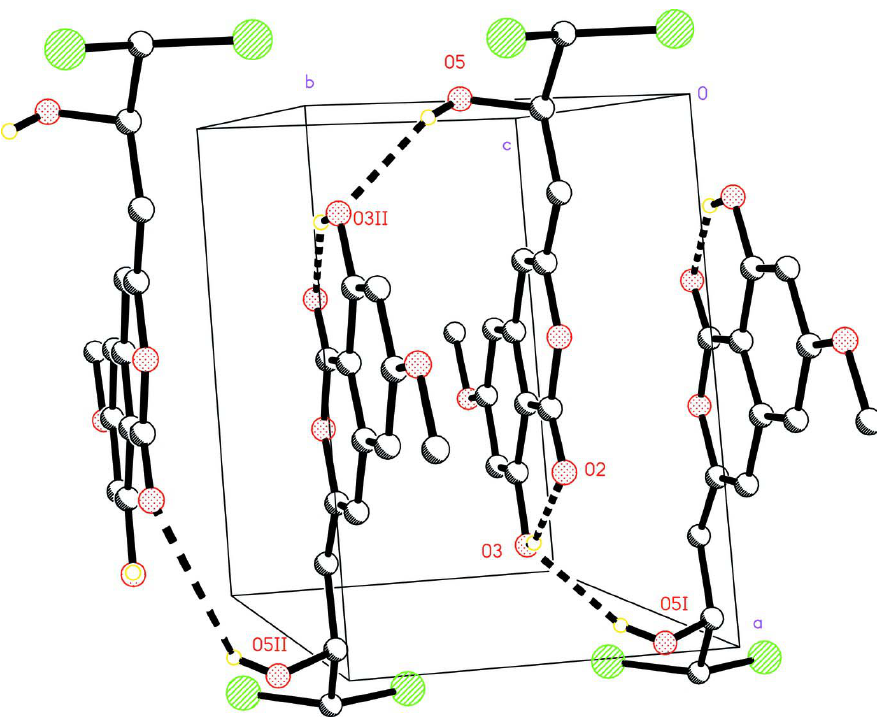
Figure 2 A view of the hydrogen-bonded molecular chains (Dashed lines). The chains are aligned parallel to the crystallographic b axis. H atoms not involved in H-bonding have been omitted for clarity. Symmetry codes: (I) 1 - x , y - 1/2,- z ; (II) 1 - x ,1/2 + y ,- z .